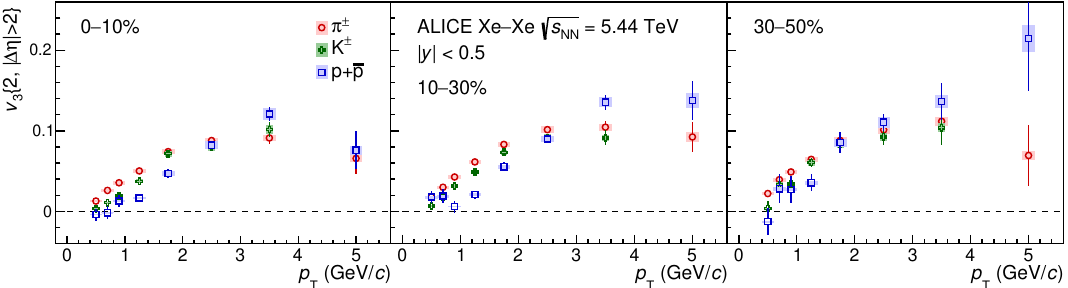
Figure 5. The p T -differential v 3 of π ± , K ± , and p+ p in a given centrality interval. Bars (boxes) denote statistical (systematic)